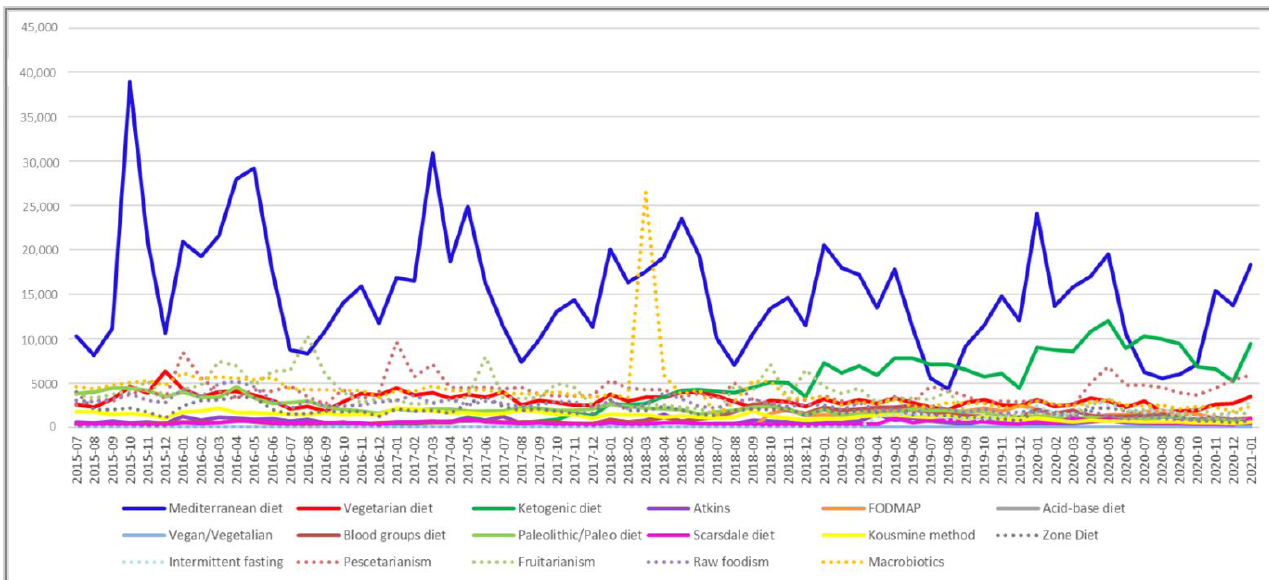
Figure 2. Wikipedia curves with reference to the number of page views for Mediterranean, vegetarian (semi-vegetarian), ketogenic, Atkins, FODMAP, acid–base, vegan, blood group, paleolithic, Scarsdale, Kousmine method, zone, intermittent fasting, pescetarianism, fruitarianism, raw foodism, and Macrobiotics diets.